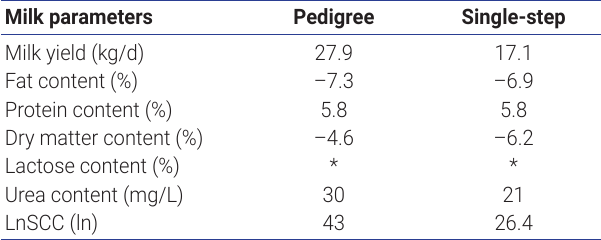
Table 4. Correlation between composite genotypes and phenotypes